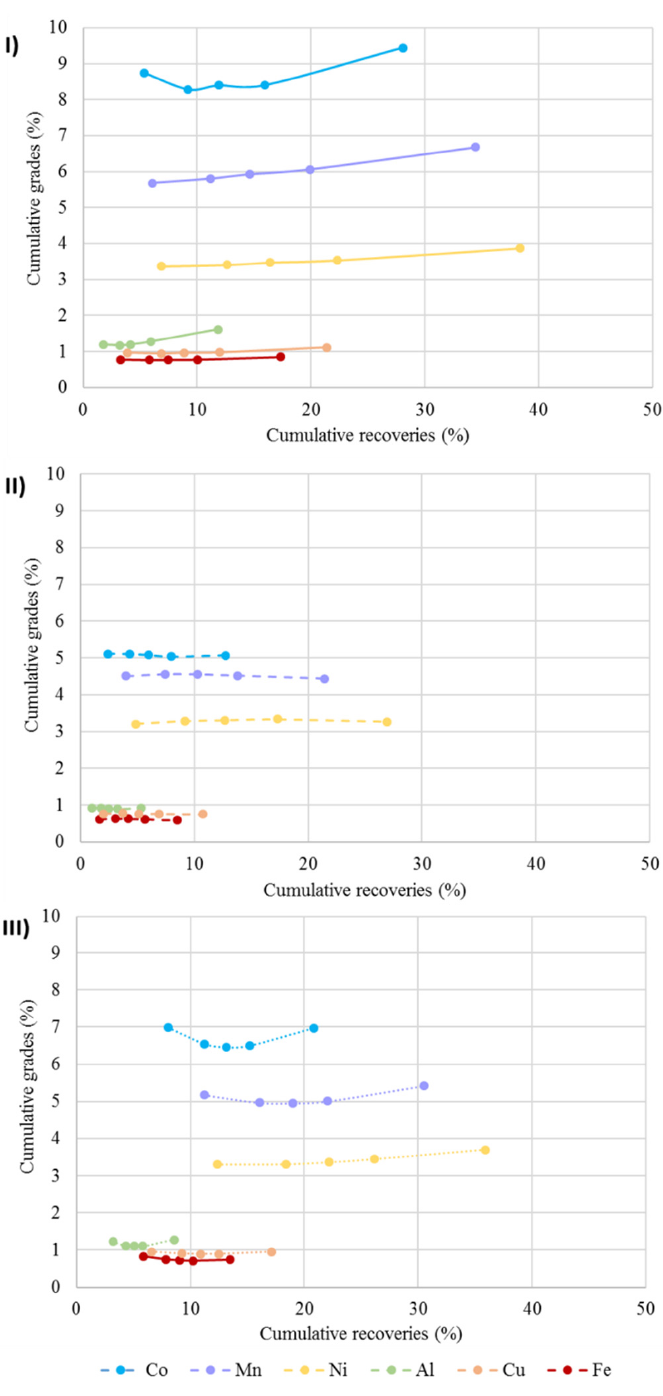
Figure 4. Grade recoveries of the impurities in the overflow products during spent black mass flotation. ( I ) No attrition, ( II ) With attrition, ( III ) Attrition with